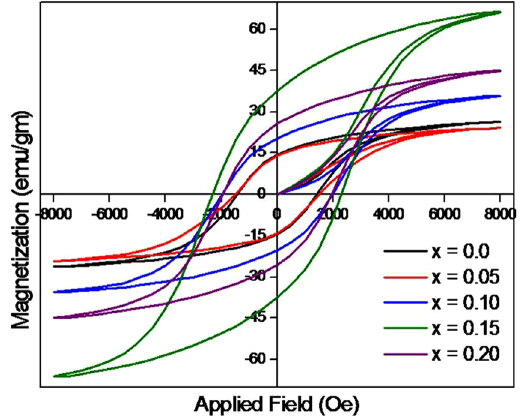
Figure 6. Magnetic hysteresis loops measured for CBF at room temperature for different ‘x’ values.